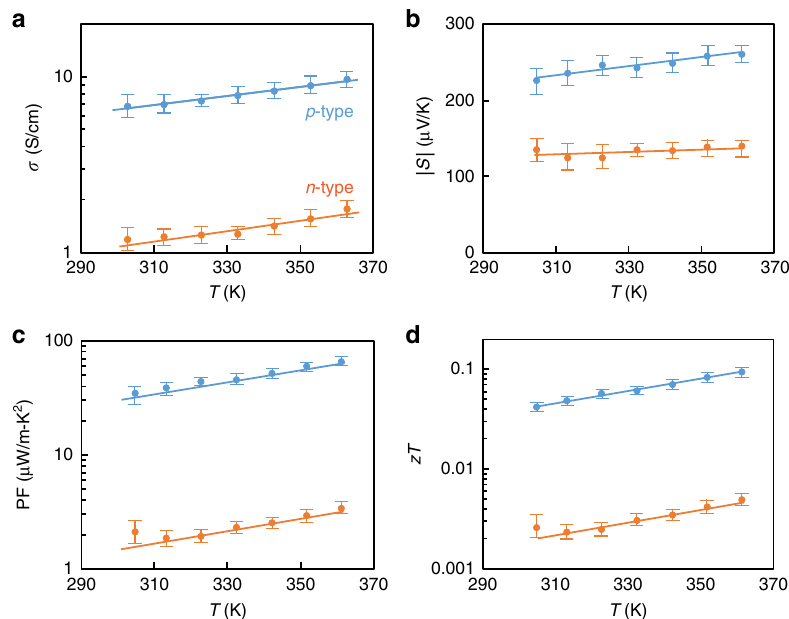
Fig. 3 The transport properties of thermoelectric threads. Under pressure p = 400kPa, a the electrical conductivity, b absolute Seebeck coef fi cient, c power factor, and d material zT with standard deviation errors, varied with increasing temperatures T , ranging from 300 K to 360 K. The measured thermal conductivity at room temperature of both p - and n -type threads was κ = 0.25 W/mK which is favorably lower than that of bulk compressed TE pellets, κ = 1.10 W/mK. Legend: blue is p- type and orange is n-